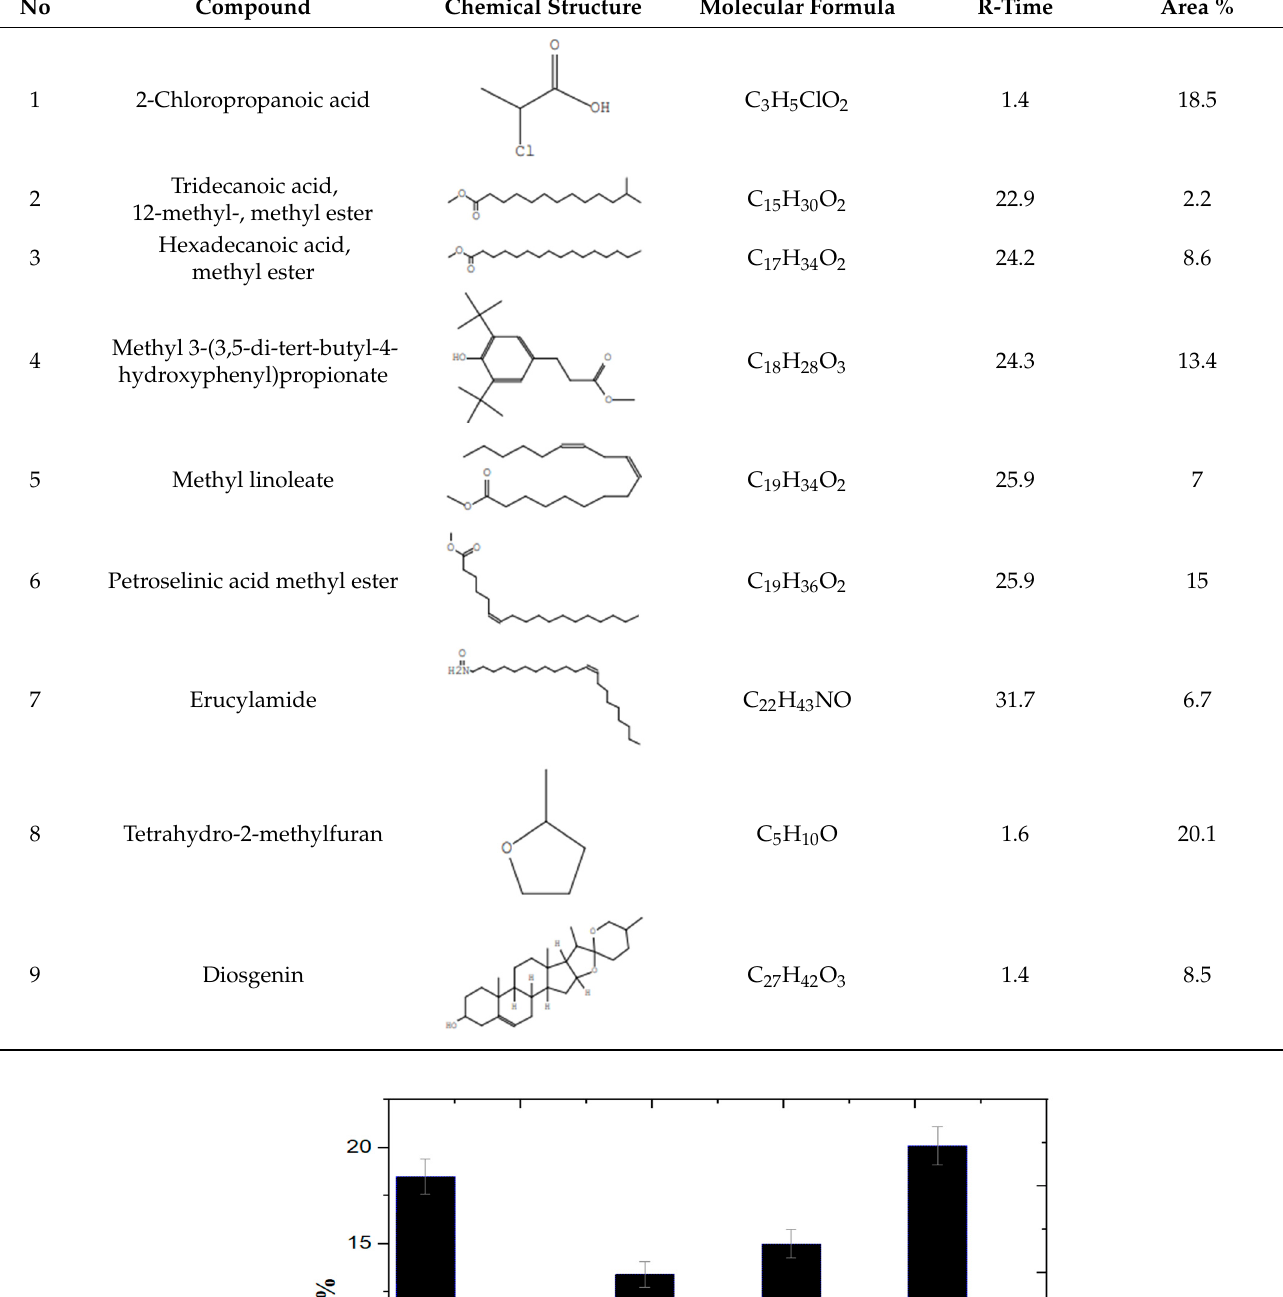
Table 2. Chemical compounds in methanolic extract of Fagonia indica based on GC–MS.